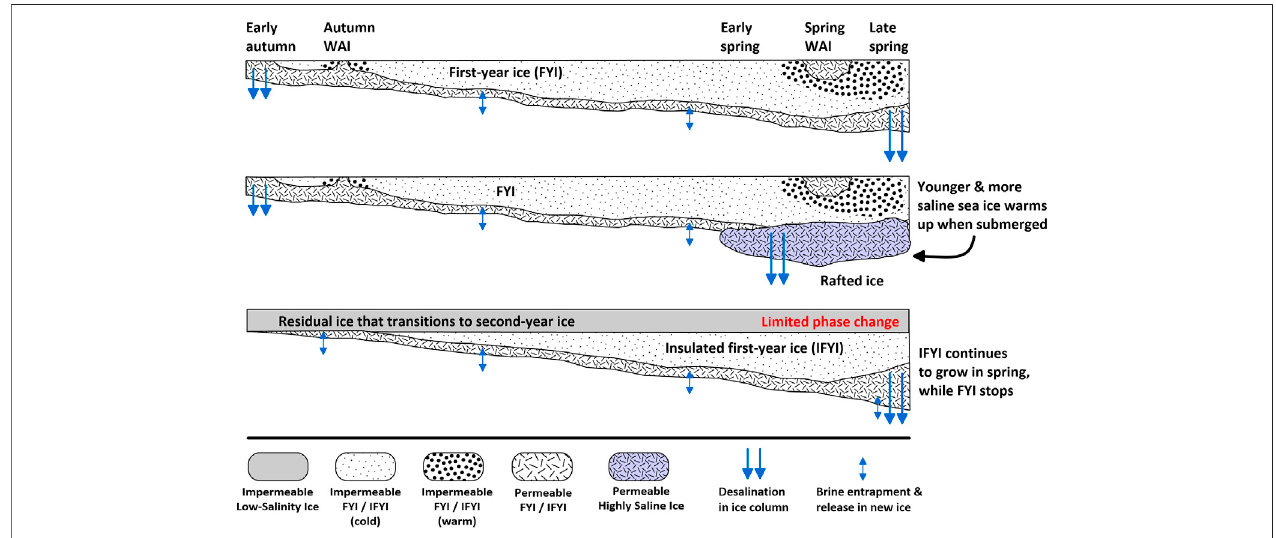
FIGURE9| Somekeyprocessesaffecting fi rst-yearice(FYI),residualandsecond-yearice(SYI),andinsulated fi rst-yearice(IFYI)growthpatterns,permeability,and desalination: atmospheric forcing, ice fl oe collisions, and ice-type dependent heat transport. The acronym WAI indicates “ warm air intrusion. ”